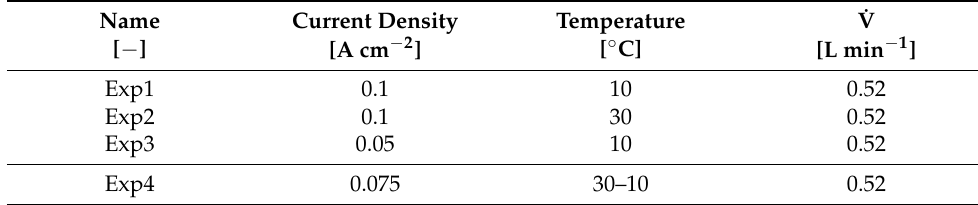
Table 3. Operating conditions of the electrochemical pH-shift crystallization experiments.